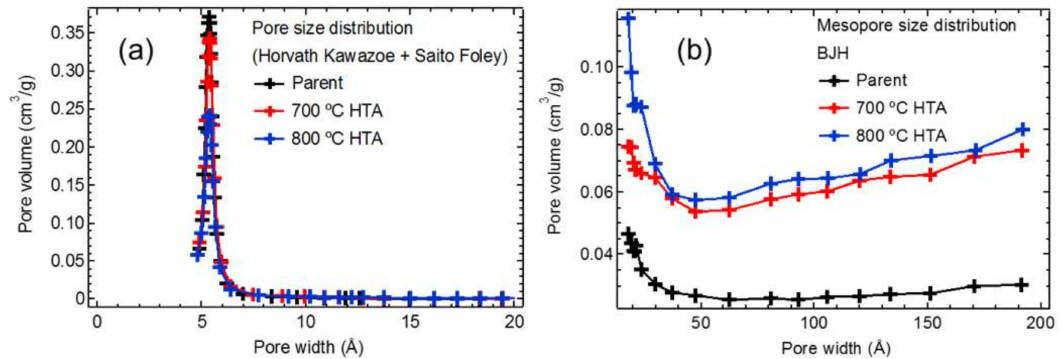
Figure 16. ( a ) Micropore size distributions of the fresh, HTA-700 and HTA-800 samples determined with the Horvath-Kawazoe and Saito-Foley methods; ( b ) Mesopore size distributions of the fresh, HTA-700 and HTA-800 samples determined with the BJH method. Reprinted with permission from ACS Catal. , 2017 , 7 , 8214–8227. Copyright 2017, American Chemical Society.